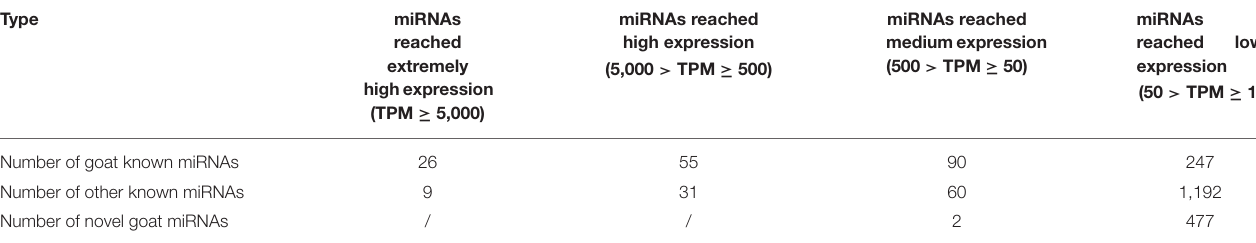
TABLE 2 | Statistic of different expression types of miRNAs.